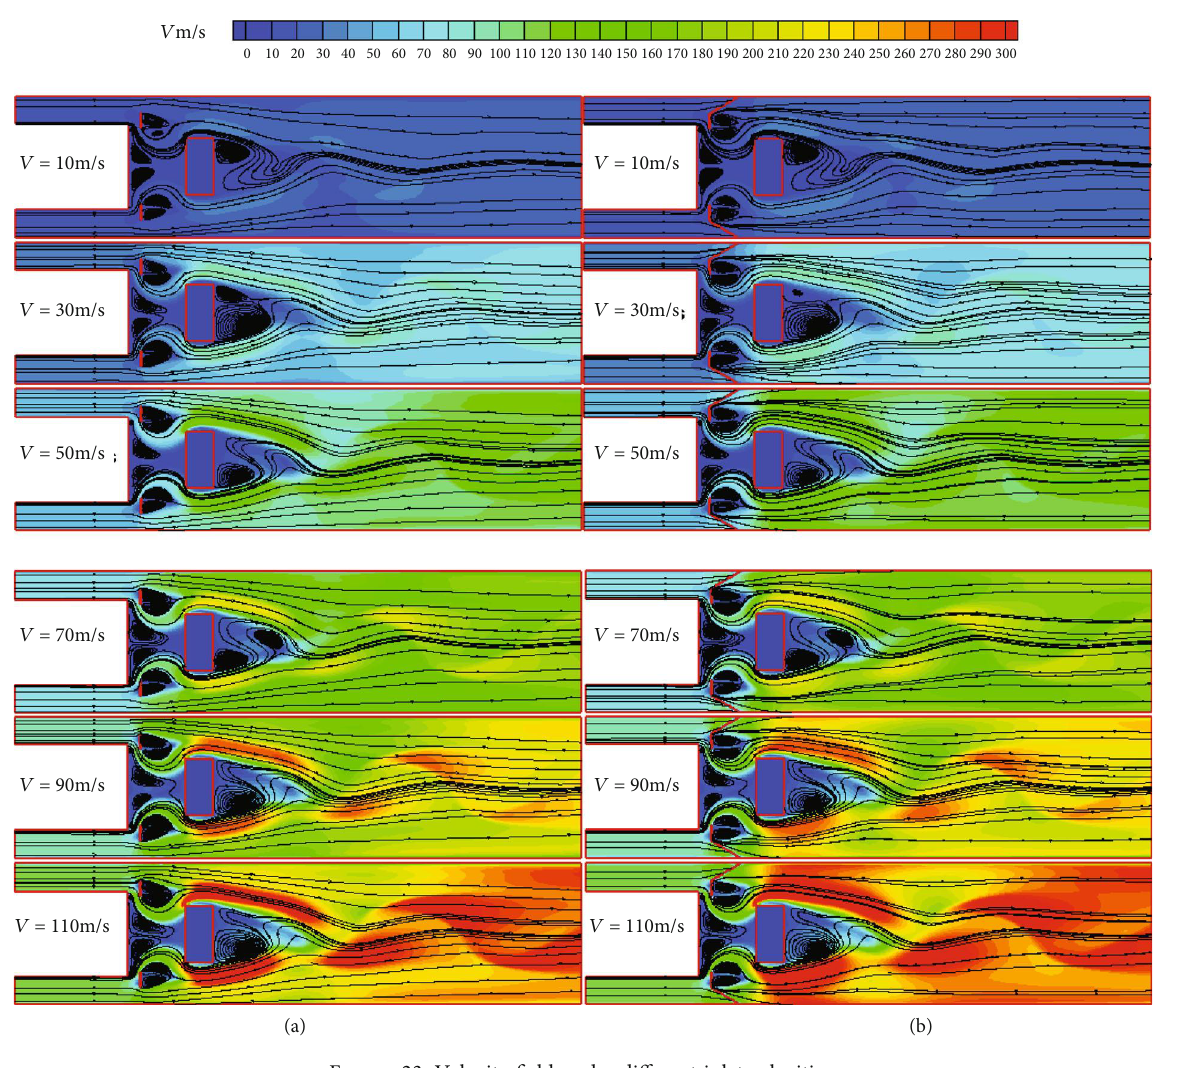
Figure 23: Velocity fi eld under di ff erent inlet